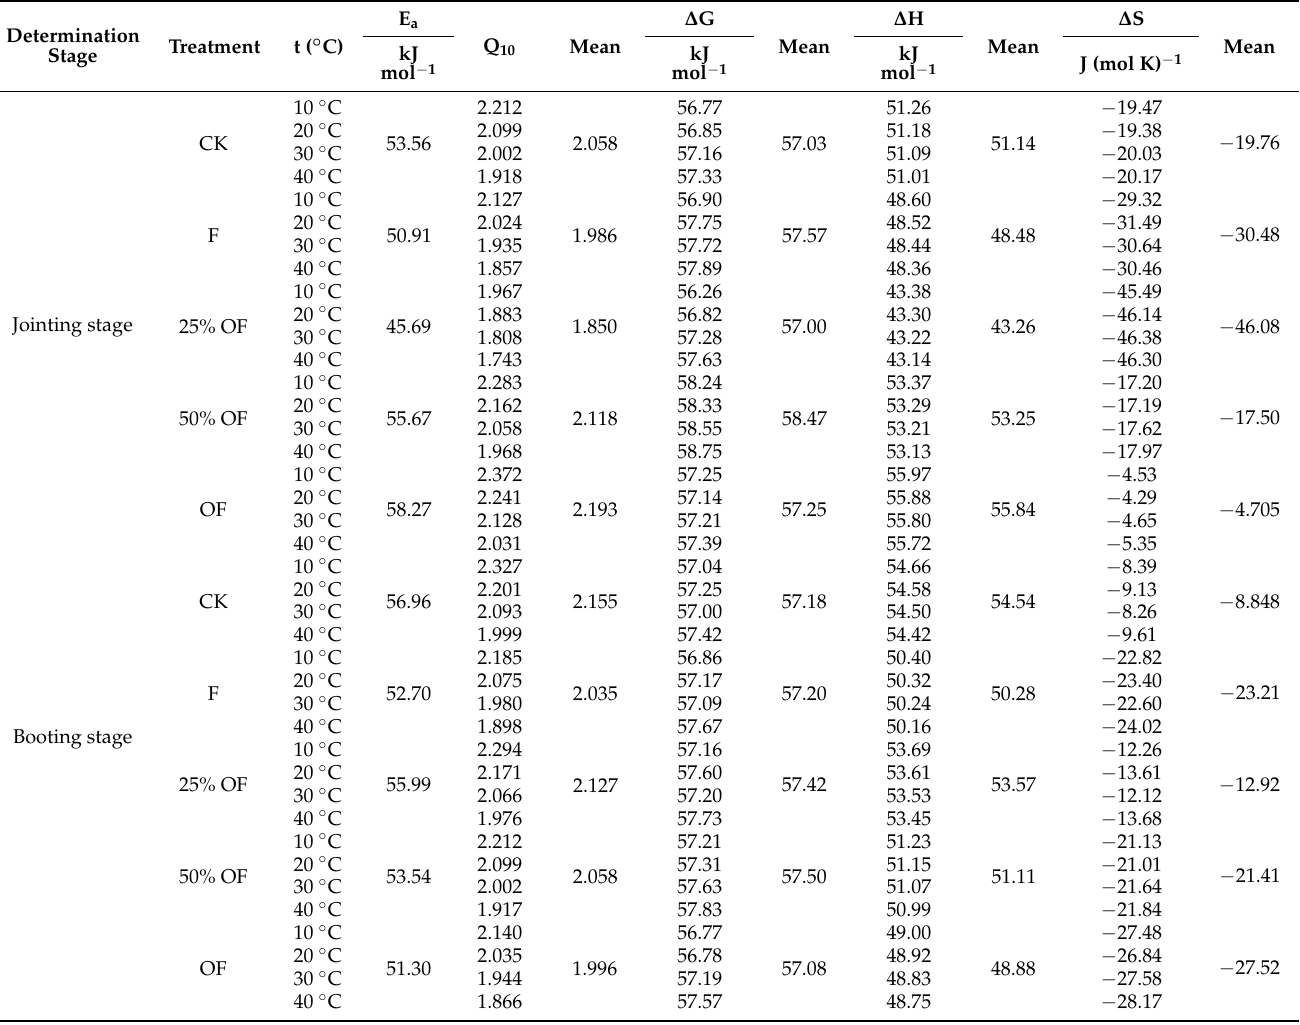
Table 3. Thermodynamic parameters of β –glucosidase in soil under different